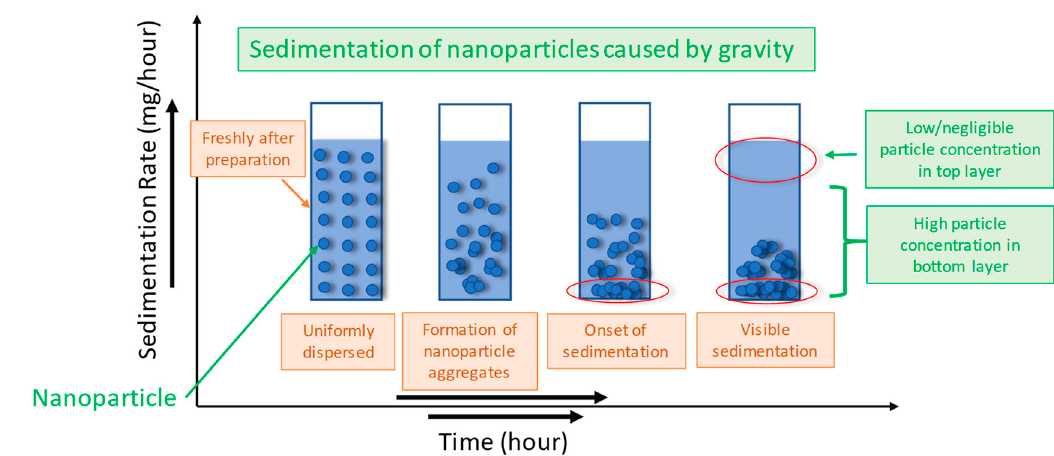
Figure 4. Scheme of sedimentation measurement.